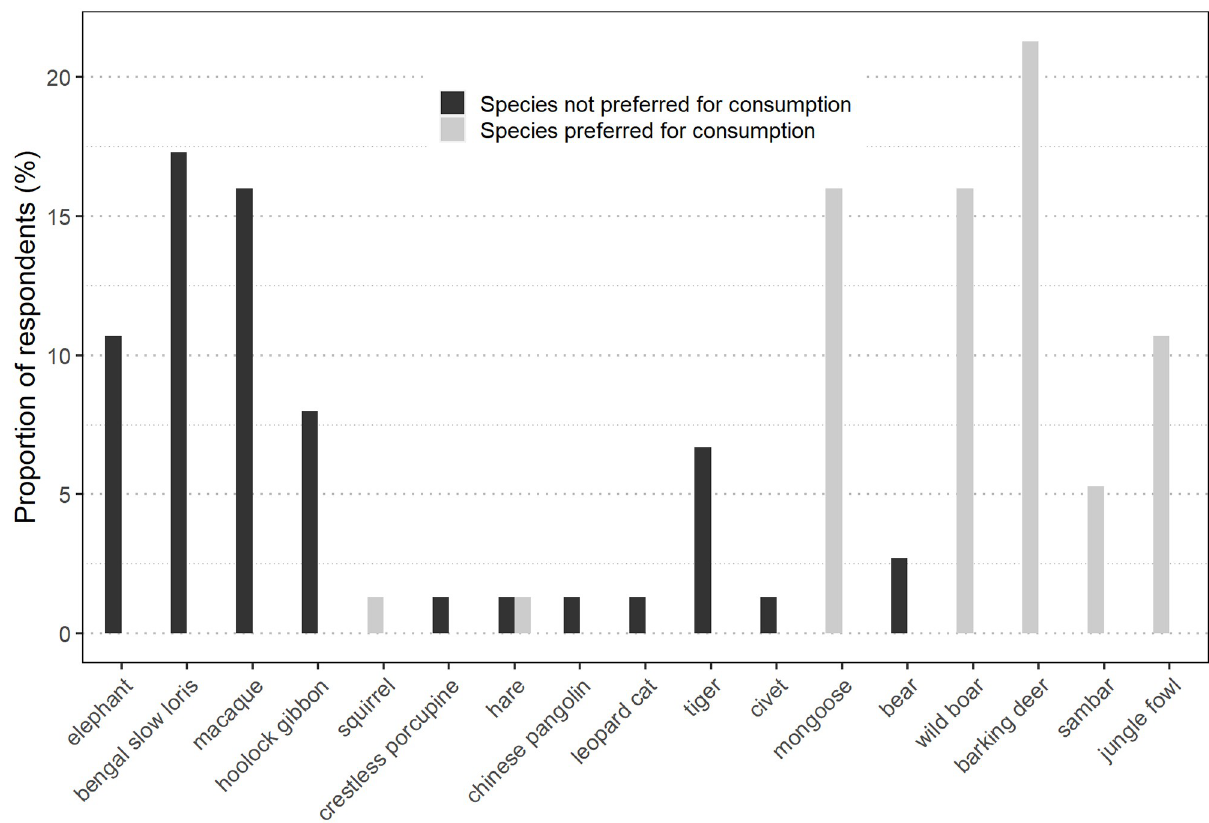
Fig 4. Species wise meat preferences of local community (n = 75) in five CRs of Ri Bhoi district.